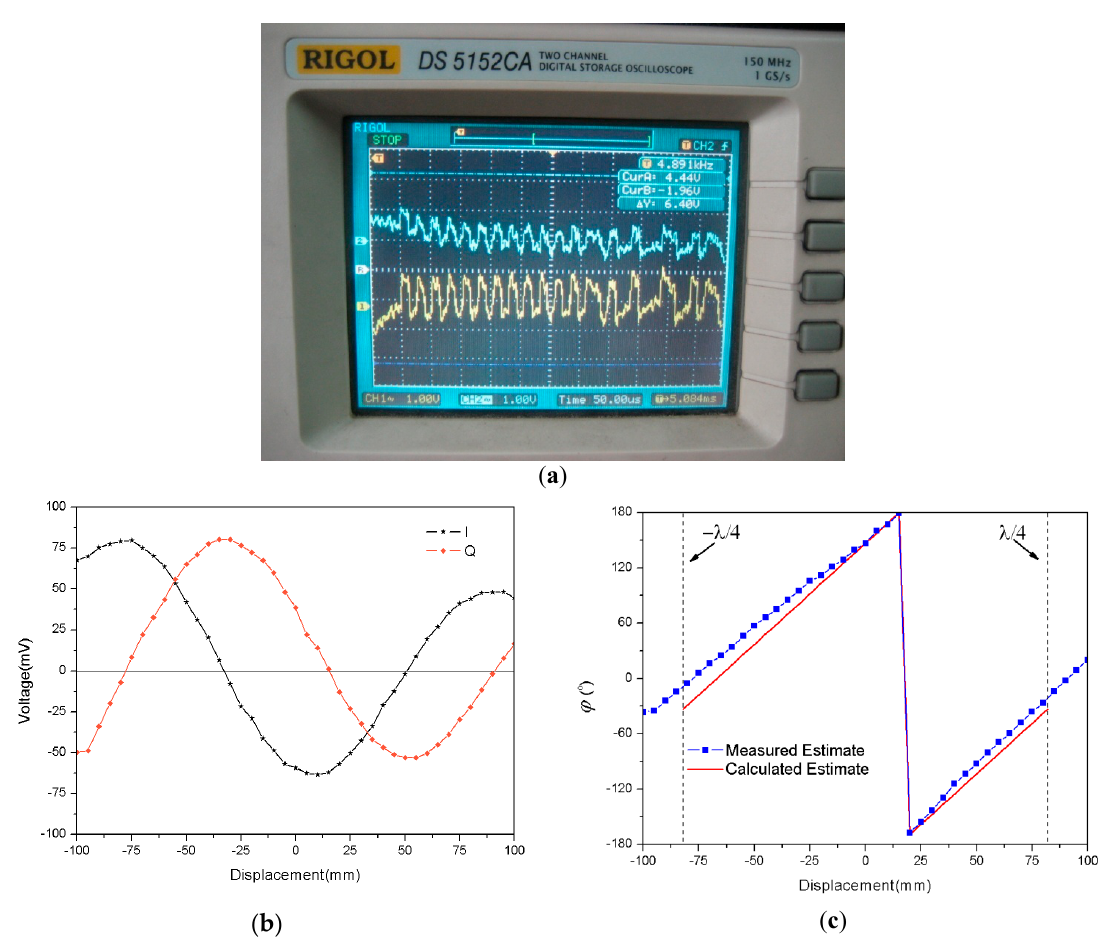
Figure 6. Displacement measured results: ( a ) Original source of measurement data; ( b ) Sampled voltages at I/Q channel; ( c ) Estimated phase as a function of displacement.